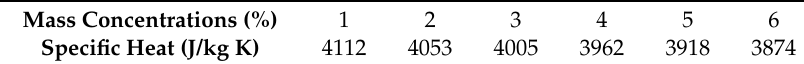
Table 4. The specific heat of aqueous sodium chloride solution.